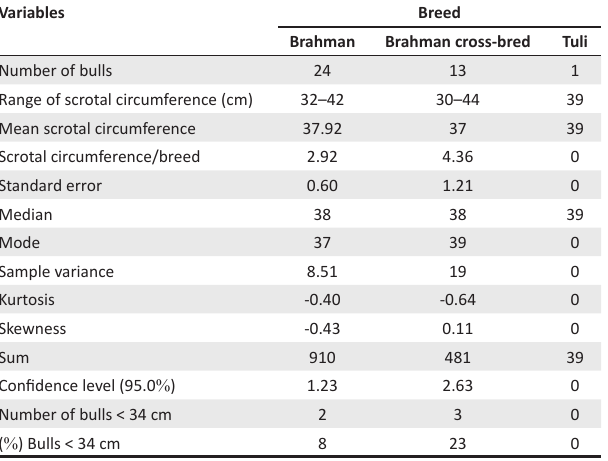
TABLE 3: Methods used by farmers for controlling ticks on their communal bulls ( n = 50).